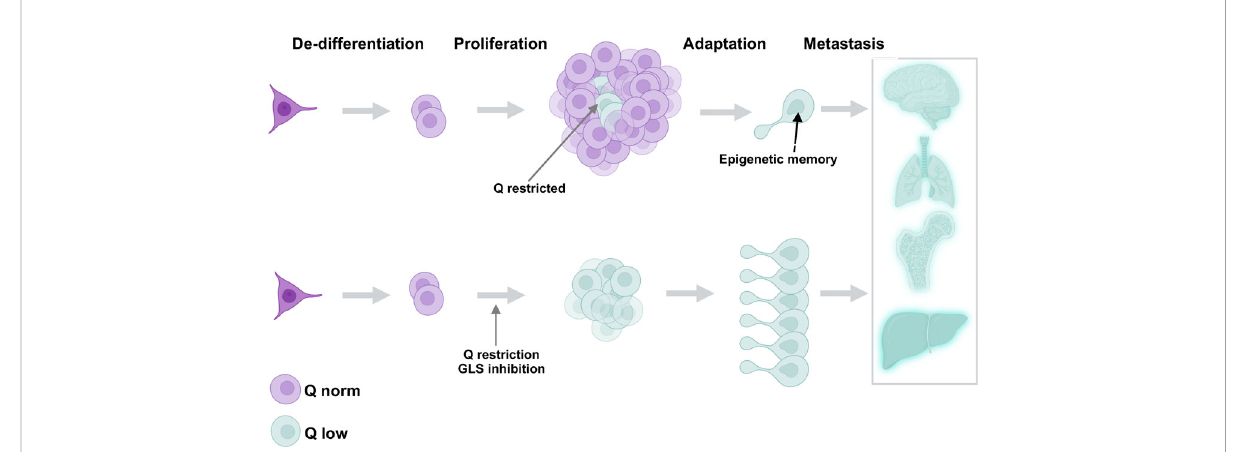
FIGURE 3 Glutamine restriction has the potential to generate more cells with metastatic potential through epigenetic adaptation. Glutamine restricted cells (aquamarine) are naturally formed in the tumor center. These cells become epigenetically transformed and exhibit the potential to metastasize and invade other tissues (upper panel). Glutamine restriction is potentially a tumor de-bulking strategy (lower panel) but may give rise to many more adapted and dangerous cells capable of